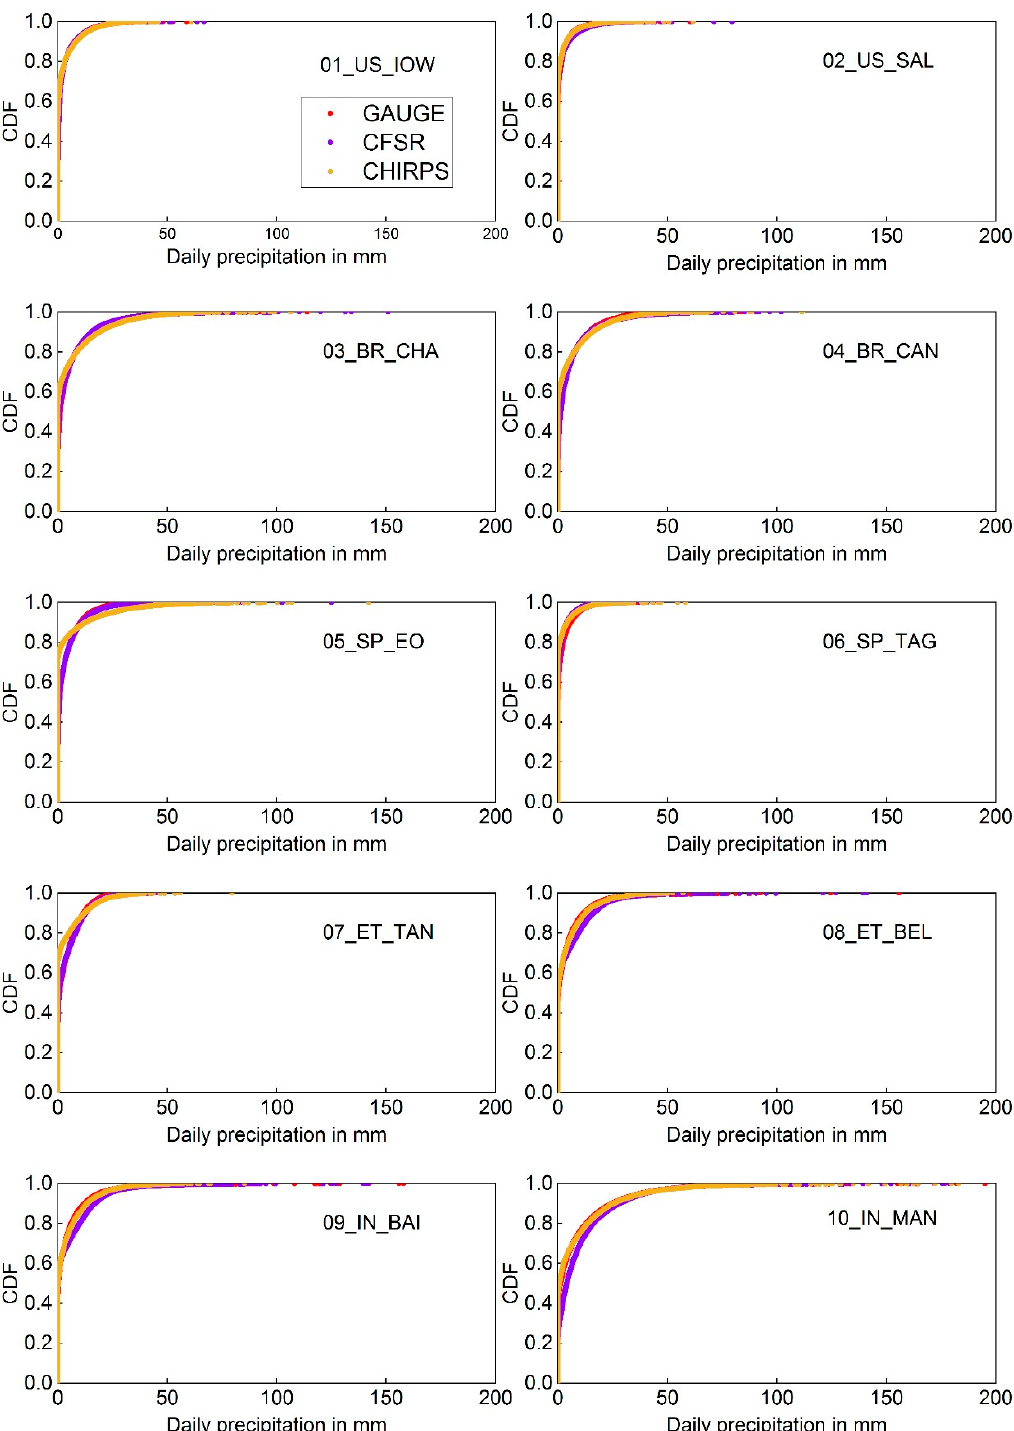
Figure 4. Cumulative distribution of monthly rainfall of the selected watersheds for 1. Gauge 2. CFSR, and 3. CHIRPS.